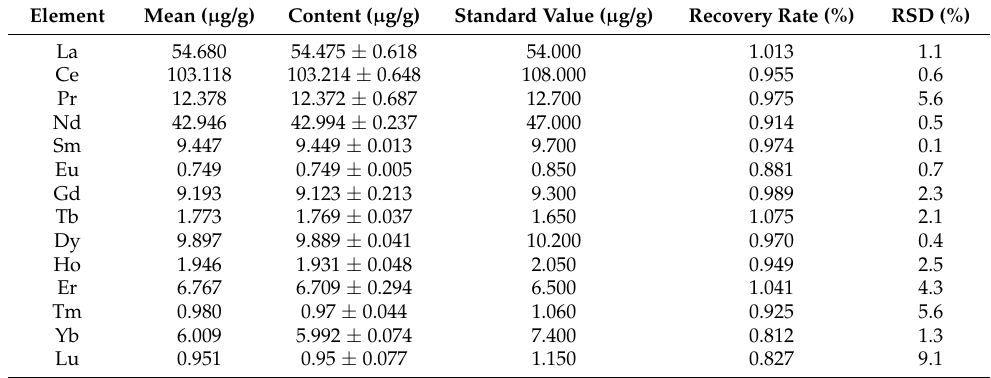
Table 1. Contents of REEs in the GBW07103(GSR-1) ( µ g/g).